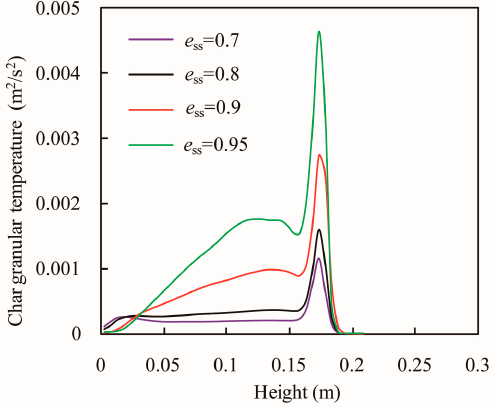
Figure 11. Axial profiles of the time-averaged granular temperature of the flotsam.